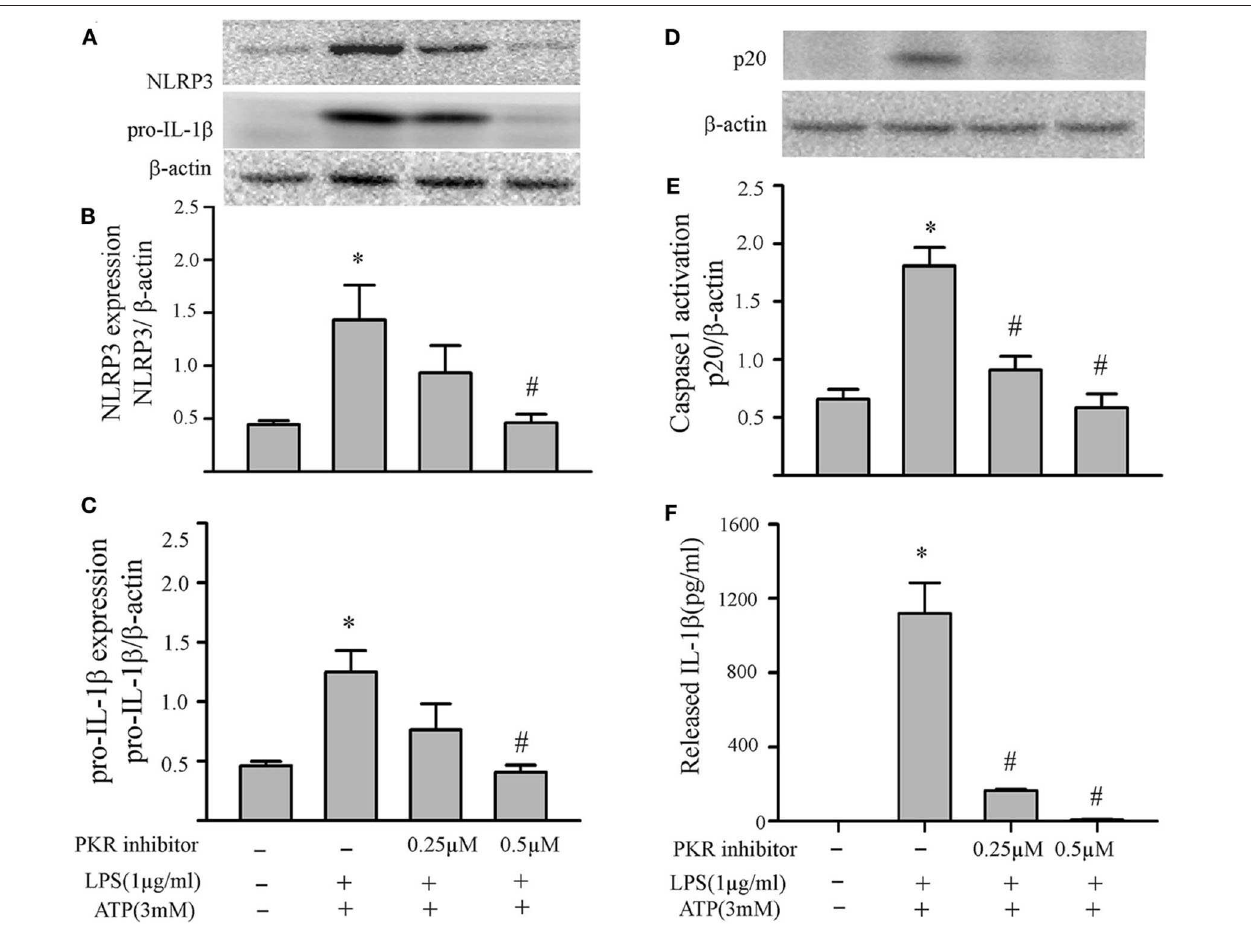
FIGURE 2 | Inhibition of PKR activity decreases NLRP3 inflammasome priming/activation in LPS/ATP challenged fibroblasts. Fibroblasts were pretreated with the PKR inhibitor (C16) for 30min. Subsequently, the fibroblasts were challenged with LPS (1 µ g/mL) for 6h followed by ATP (3mM) for 30min. (A–C) NLRP3 and pro-IL-1 β protein levels were indices of inflammasome priming. Representative Western blots are shown in (A) and densitometric analyses in (B,C) . (D–F) Caspase 1 activation (p20) and release of mature IL-1 β were indices of inflammasome activation. Representative Western blot for caspase 1 p20 is shown in (D) and densitometric analysis in (E) . Protein levels of IL-1 β were assessed in supernatants by ELISA. n = 3, * p < 0.05 as compared with control; # p < 0.05 as compared with LPS +